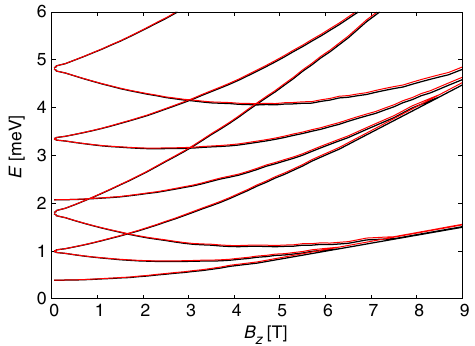
FIG. 6 Spectrum of a 40 nm WS 2 QD as a function of the perpendicular magnetic field B found in Table I and we used g (cf. Fig. 5). Black (red) lines show spin ↑ ( ↓ ) states from the K ( K 0 )